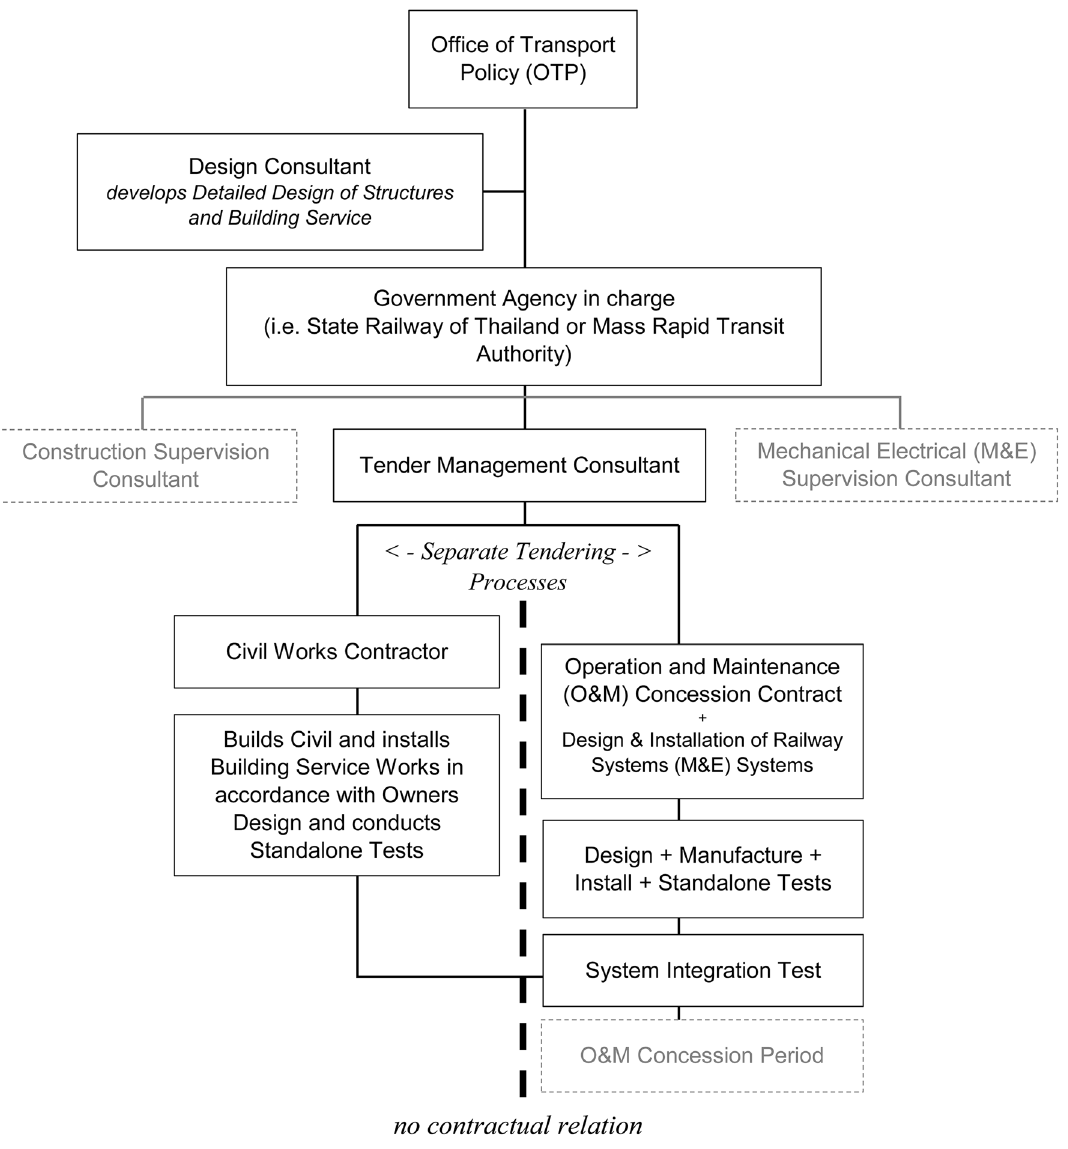
Fig. 1 Owner’s design scheme for civil and building engineering works demonstrating no relationship between the mass transit station construction design and railway systems implementation by an O&M